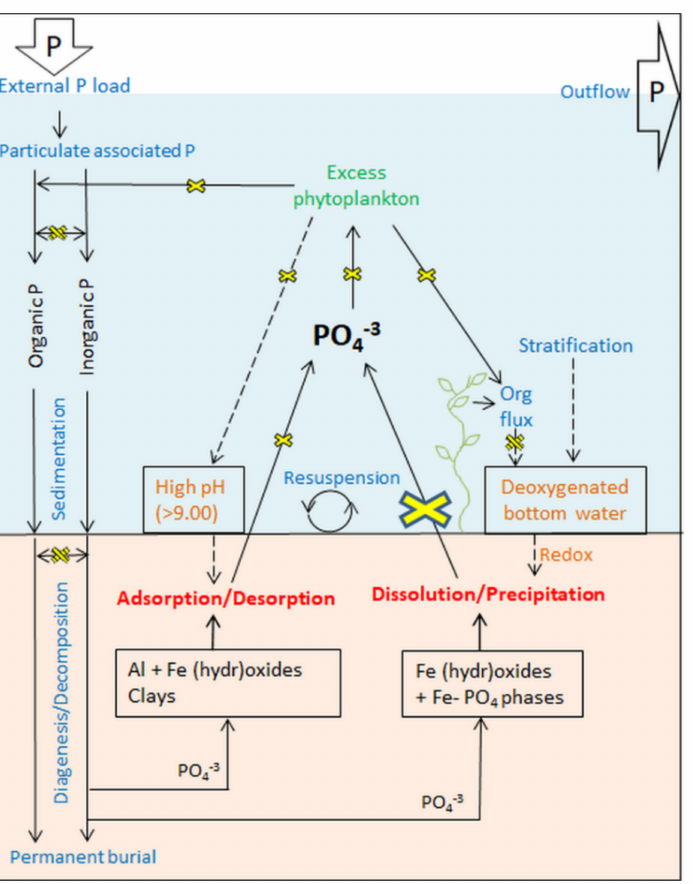
Figure 1. A simplified phosphorus cycle in lake systems showing the dominant processes and pathways of phosphorus cycling between the sediment and water column. The solid lines and blue type refer to physical processes or transport, the dashed line and red type refer to geochemical effect or process, the orange type refers to geochemical state, and the green type refers to a biological effect. The large yellow cross is the point at which most P inactivation agents attempt to block the phosphorus flux from sediment to the water column, while the smaller clear yellow crosses denote the cascading effects of such interventions, and the small hashed yellow crosses denote a decreased magnitude of